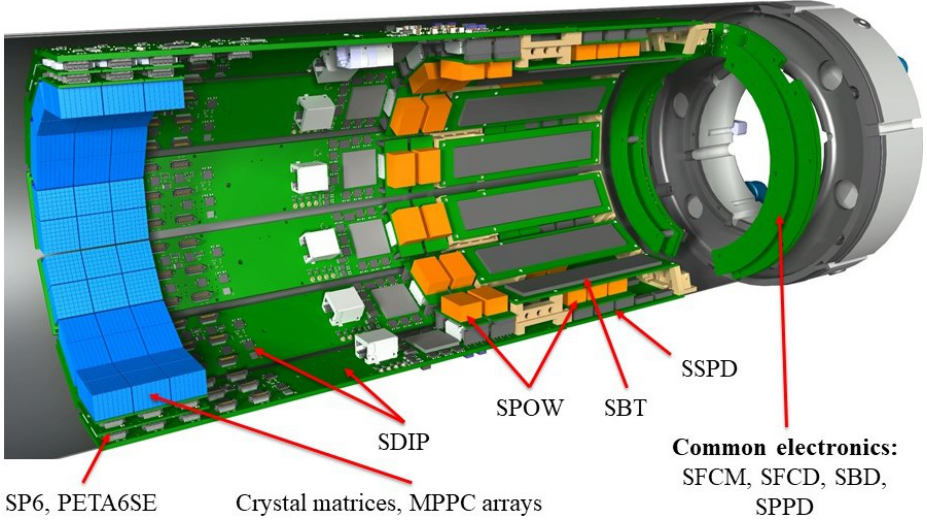
Figure 1. View of the SAFIR-I detector